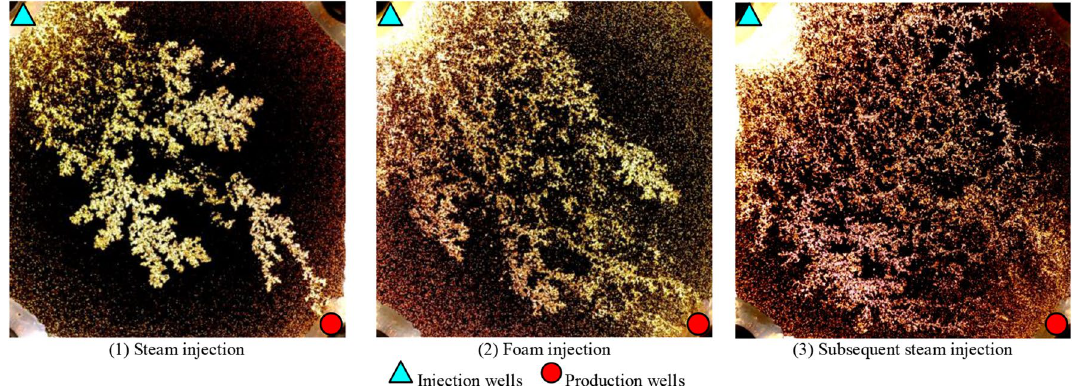
Fig. 5 The comparison diagram of areal swept zone of test